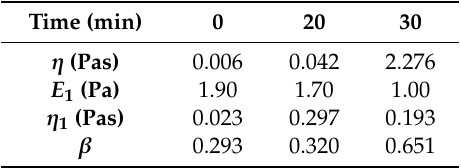
- - - - - - - - , 72 ° C , , 72 ° C , , 72 ° C , , 72 ° C ,